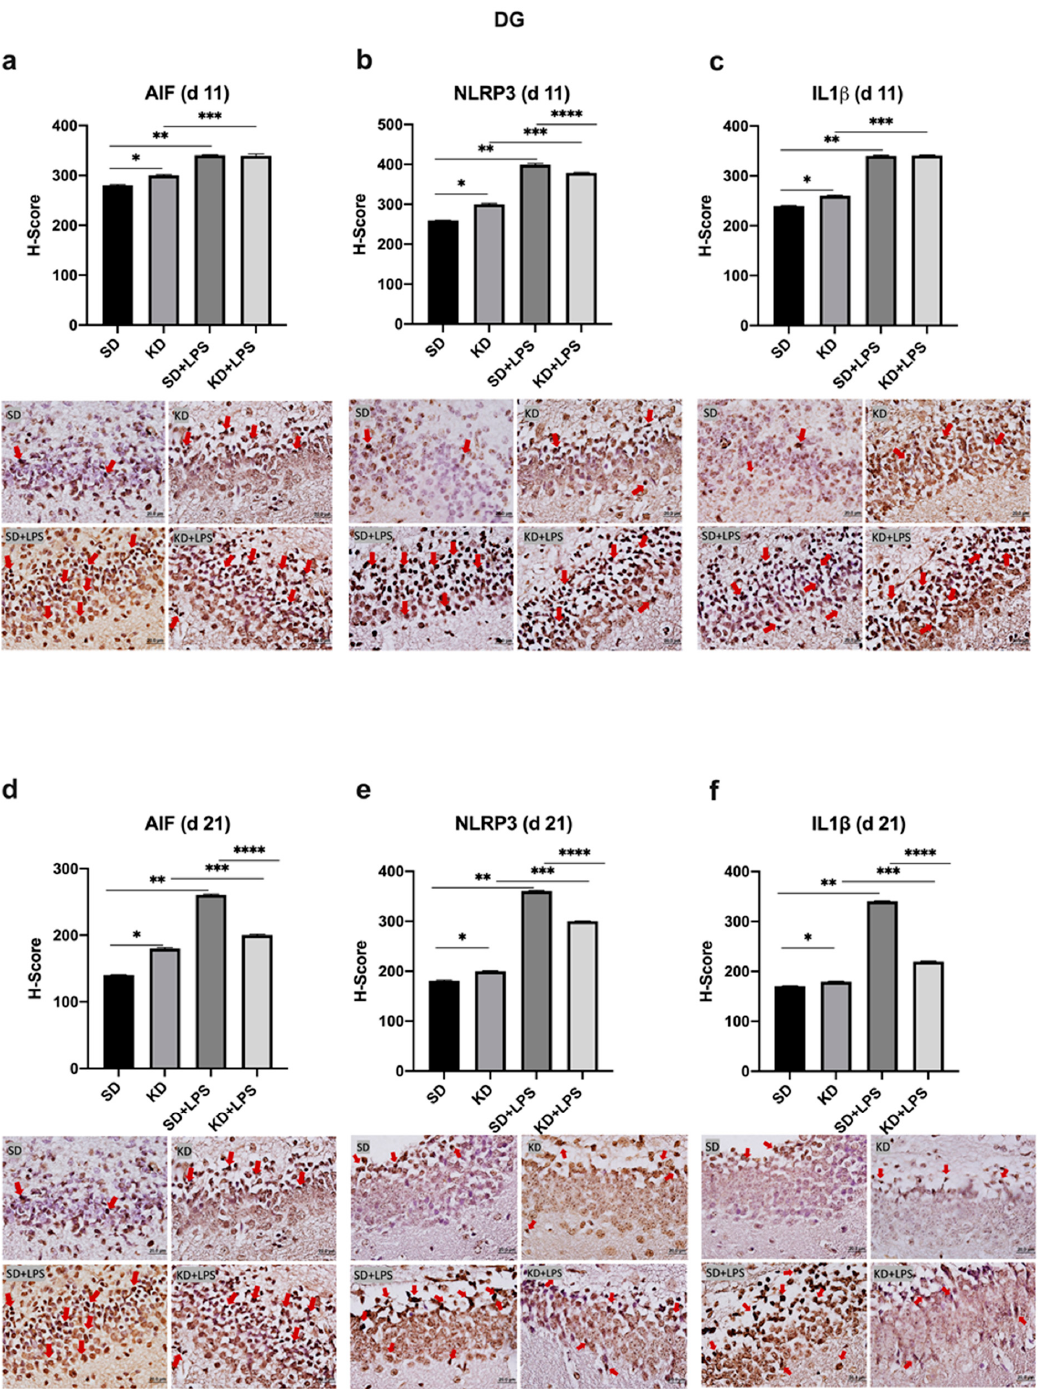
Figure 5. Immunohistochemical H-scoring and staining of the CA1 region of the hippocampus with AIF, NLRP3 and IL1 β on postnatal days PN11 and PN21. IHC images are compatible with the graphic above. Red arrows indicate immunopositive cells. *, **, ***,**** p < 0.05. AIF1, NLRP3 and IL1 β expression was increased in the CA1 of the KD group when compared to the SD group at PN11 and PN21 ( a – f ). AIF, NLRP3 and IL1 β expression was increased in the LPS-treated groups when compared to saline treated groups ( a – f ).